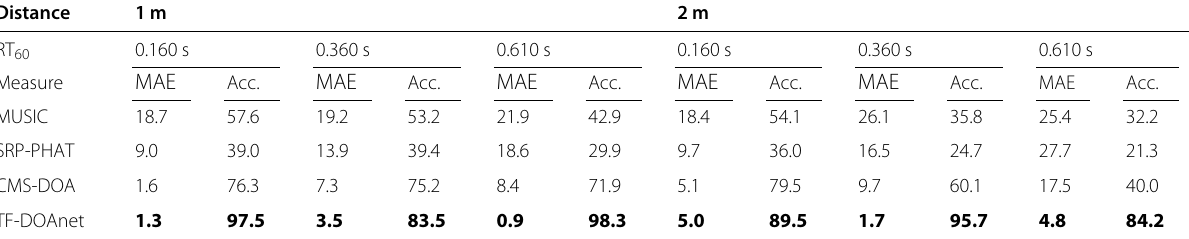
Table 5 Results for three different rooms at distances of 1 m and 2 m with measured RIRs